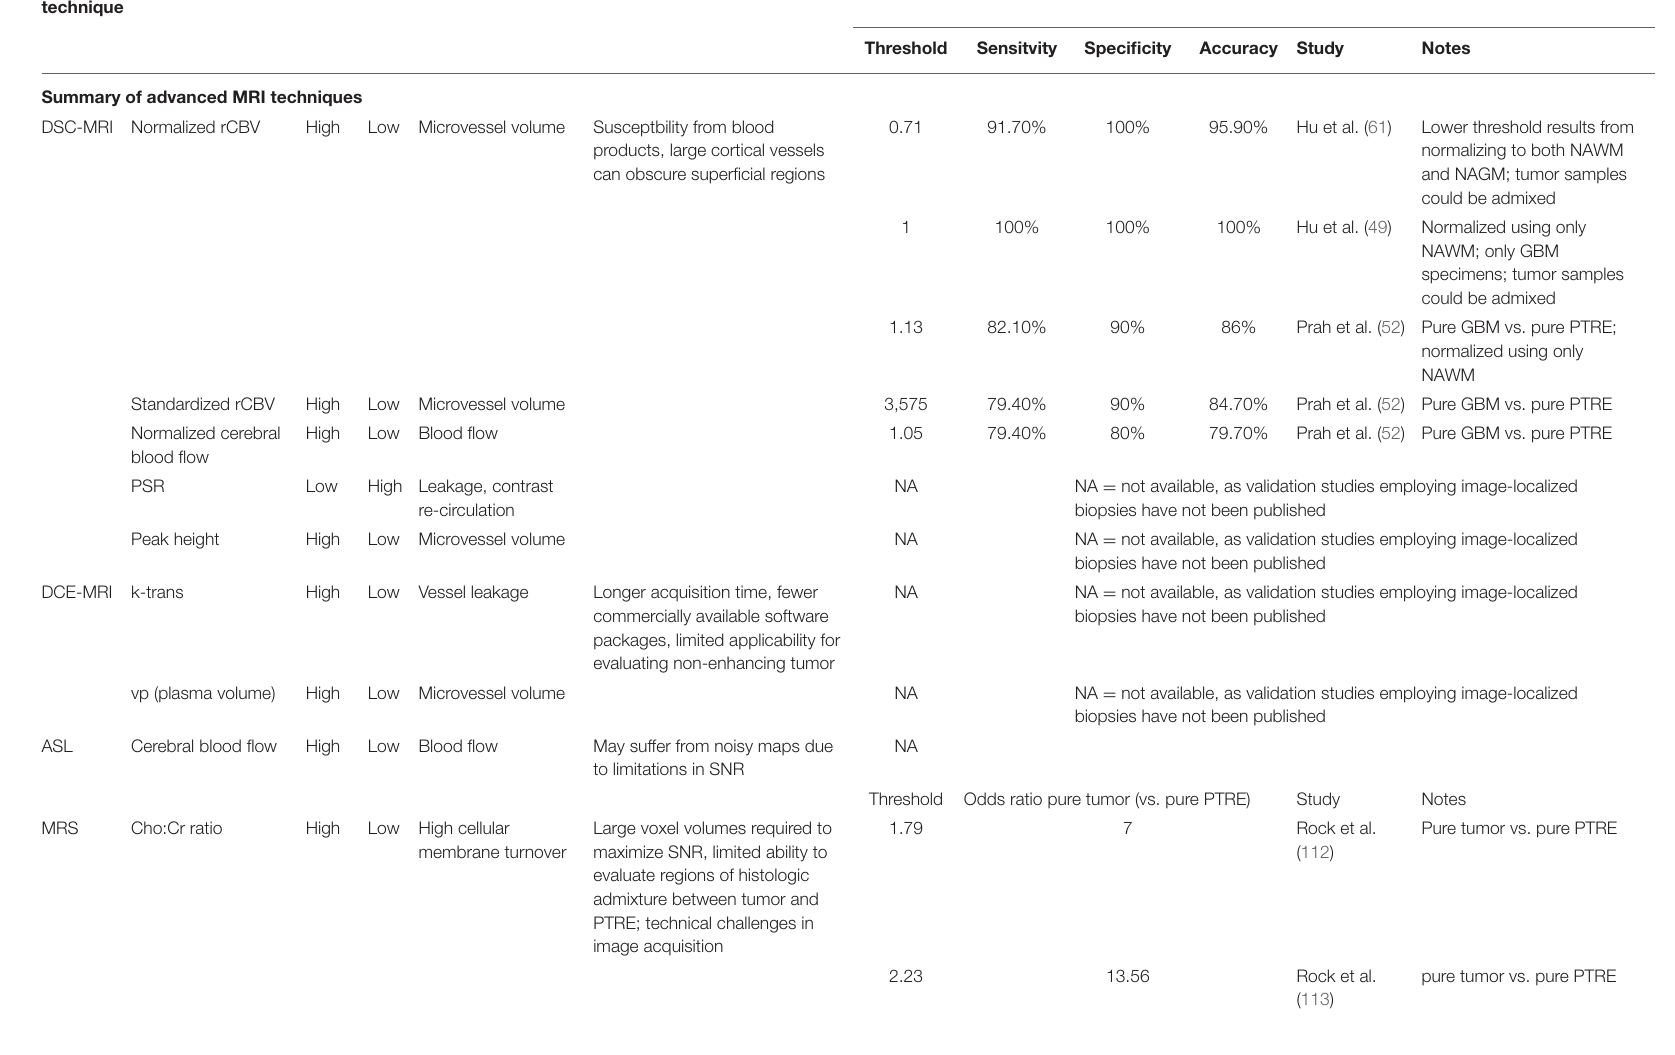
TABLE 2 | Summary of advanced MRI techniques and recommended thresholds for clinical